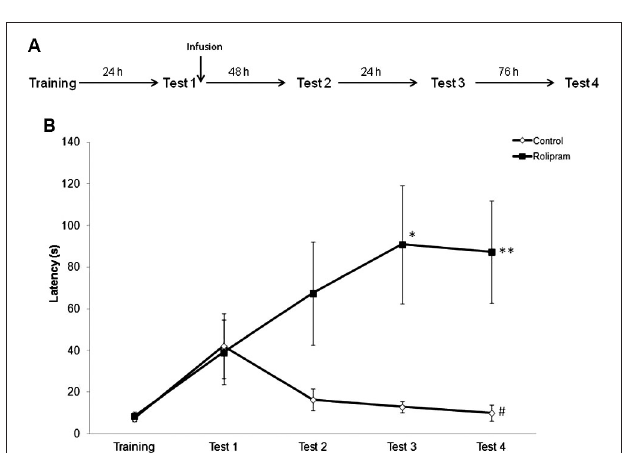
FIGURE 4 | Persistence of the memory enhancement induced by rolipram administration after retrieval . Rats were given an IA training trial followed by retention test trials at 24 h (Test 1), 72 h (Test 2), 96 h (Test 3), and 7 days (Test 4) later. Vehicle ( N = 10) or rolipram (7.5 µ g/side, N = 9) was infused immediately after Test 1. (A) Schematic diagram showing the experimental design. (B) Vehicle-treated rats showed extinction of IA memory, whereas rats infused with rolipram showed memory strengthening, across test trials; * P < 0.05, ** P < 0.01 compared to the vehicle group within the same behavioral trial; # P < 0.05 compared to Test 1 within the same group.